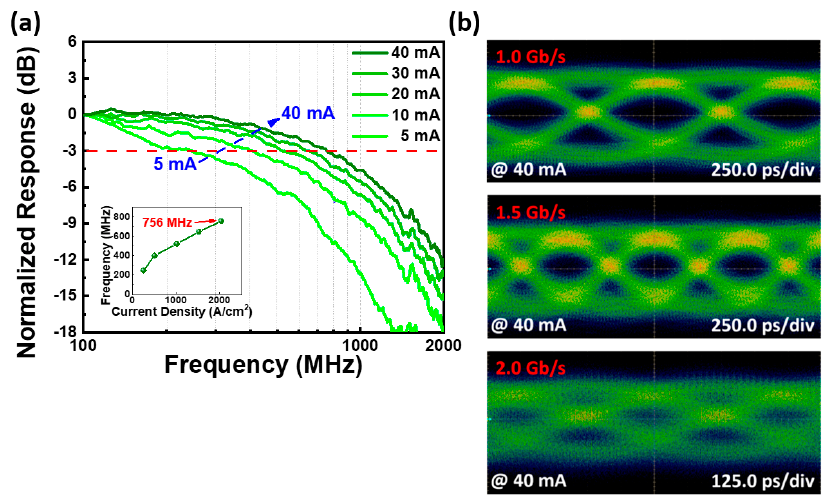
Figure 6. ( a ) Frequency response measurement; ( b ) eye diagram for the data rate measurement. [60] Figures reproduced with permission from ACS